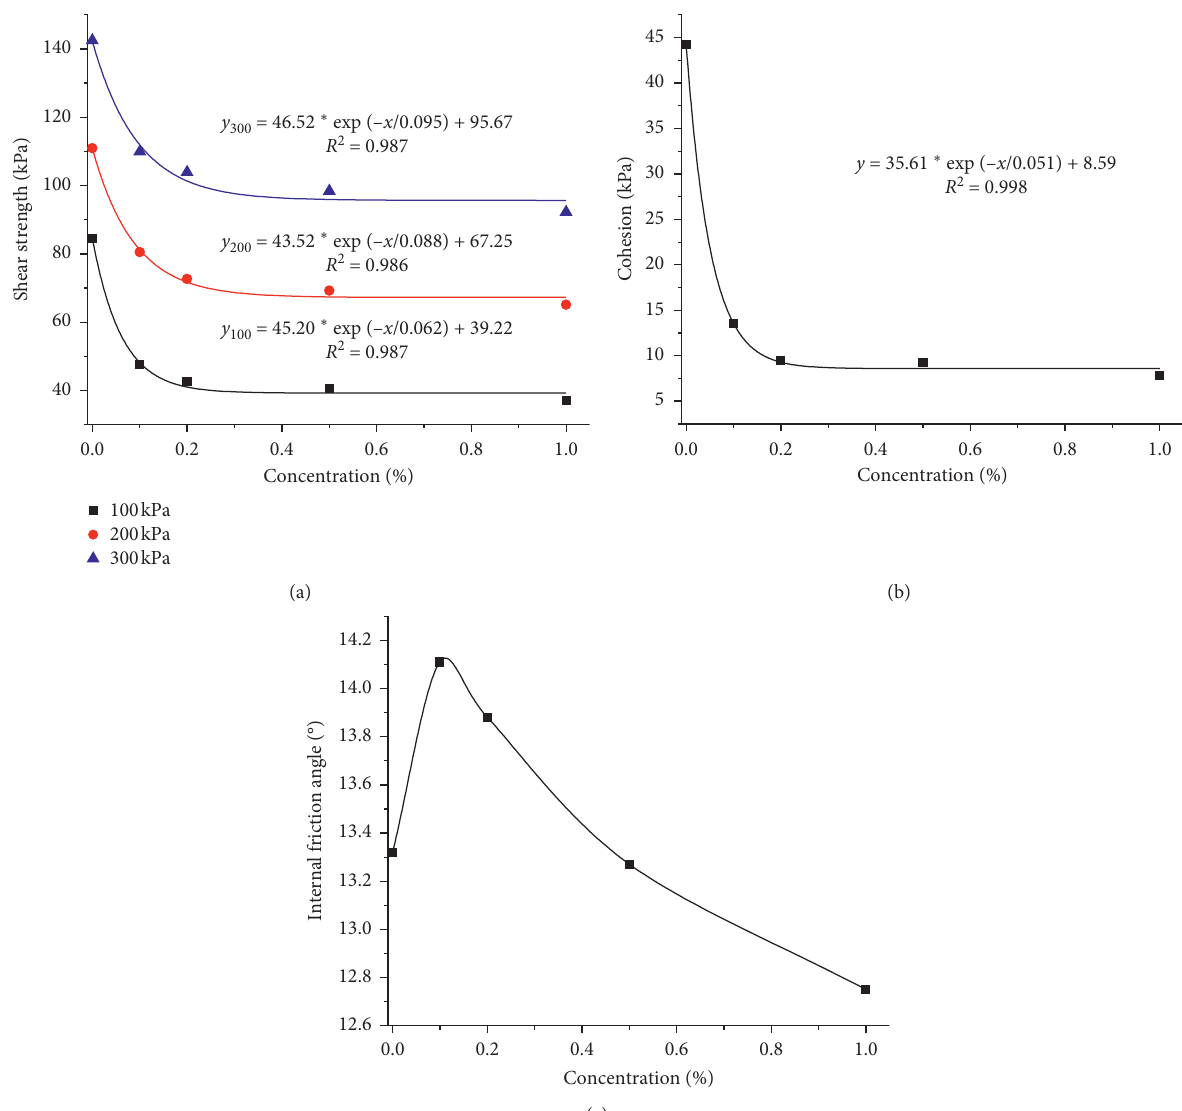
Figure 3: Relationship curves between zinc ion concentration and shear strength index. (a) Fitting curve of the relationship between zinc ion concentration and shear strength. (b) Fitting curve of the relationship between zinc ion concentration and cohesion. (c) Curve of the relationship between zinc ion concentration and internal friction